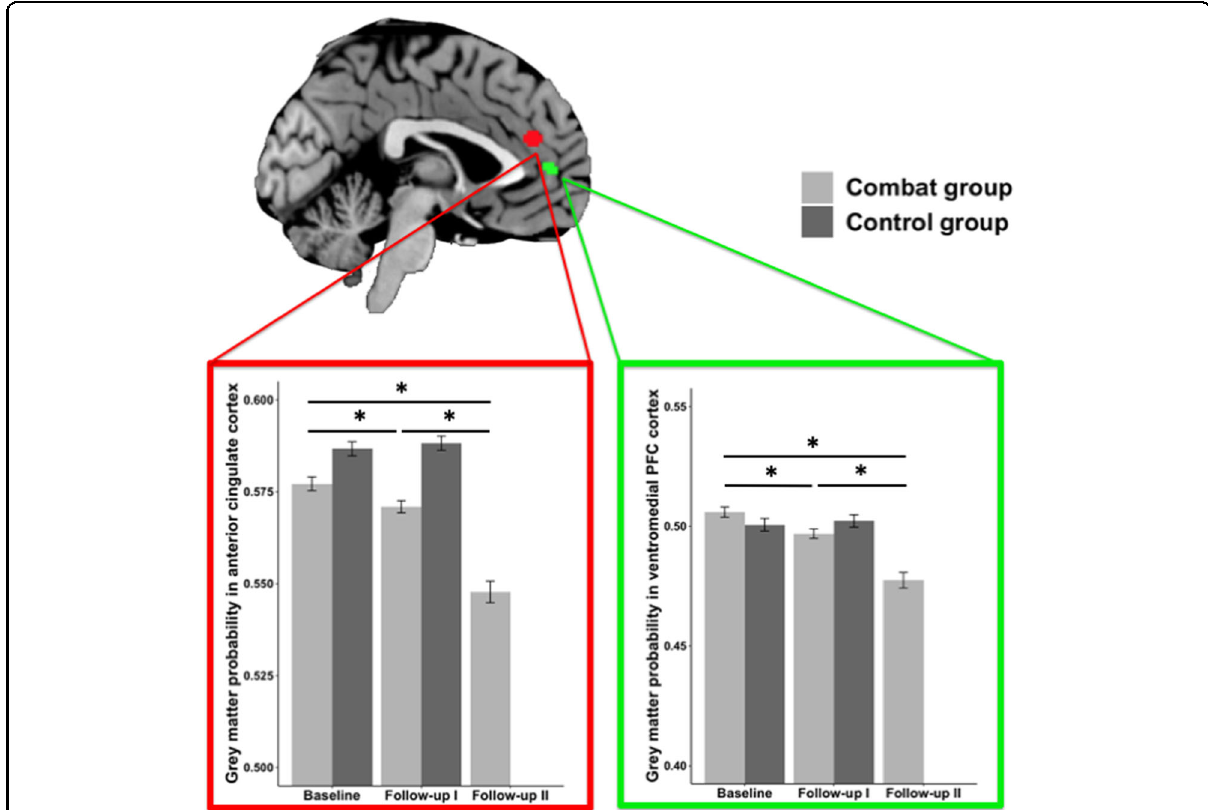
Fig. 1 On top the two regions of interest in anterior cingulate cortex (ACC, 0, 40, 21) and ventromedial prefrontal cortex (vmPFC, 0, 49, 6) from a previous meta-analysis comparing PTSD patients and trauma-exposed controls 4 are displayed. On the bottom illustration of the mean gray matter volume extracted from the two ROIs displayed on top. Additionally, mean values for Follow-up II about 6 months after the deployment are shown. Each asterisk indicates signi fi cant a result of a paired t -tests ( p < 0.05). Within-subject error bars are computed based on Morey 39